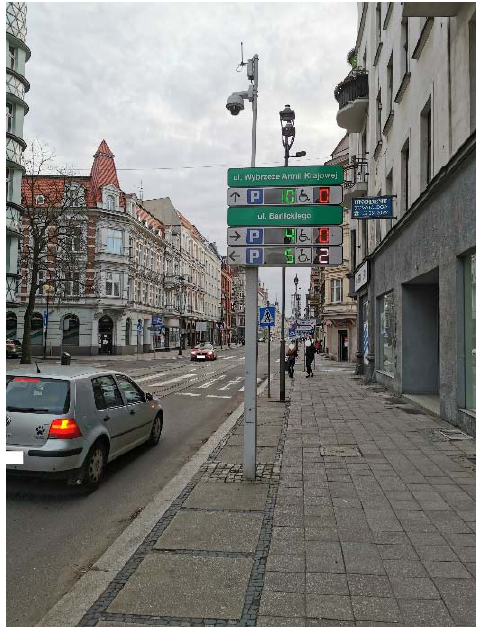
Figure 3. Dynamic parking information board in PPZ covered by DPI in Gliwice.